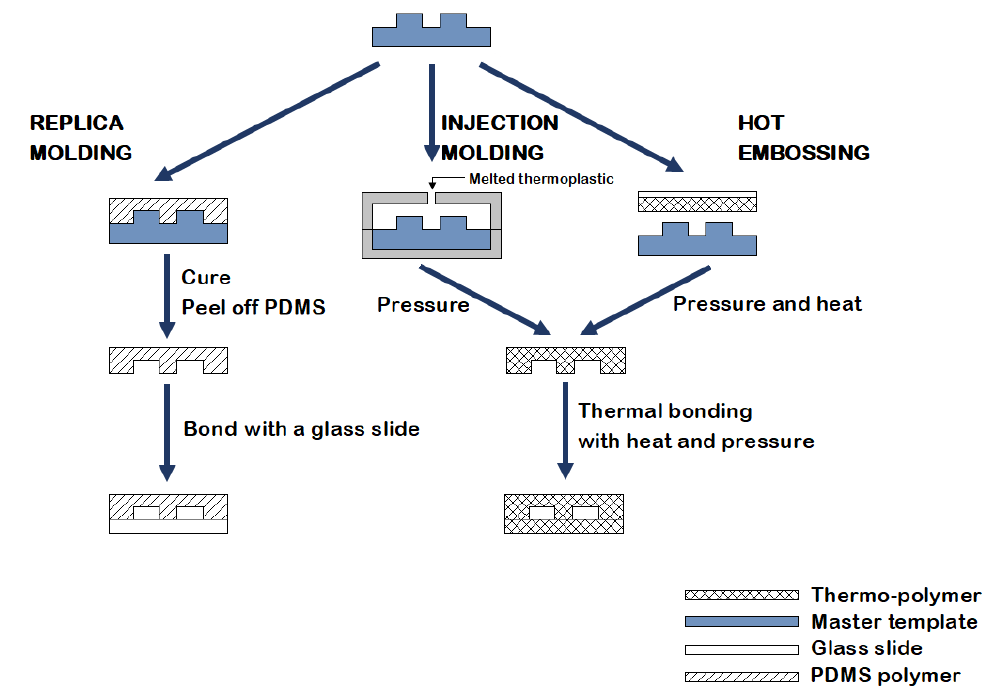
Figure 3. An illustration of the fabrication methods currently used in microfluidics: replica molding, injection molding, and hot embossing.